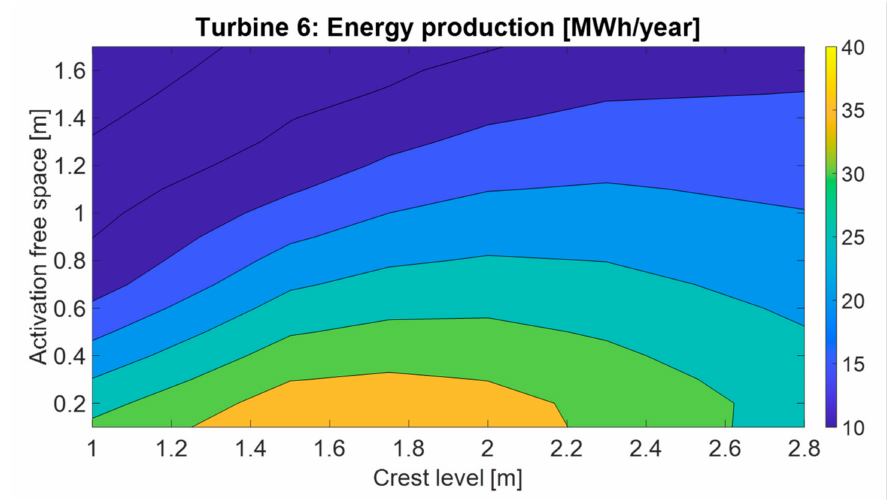
Figure 12. Energy produced by Turbine 6 as a function of the activation free space f a and the crest level h cr .